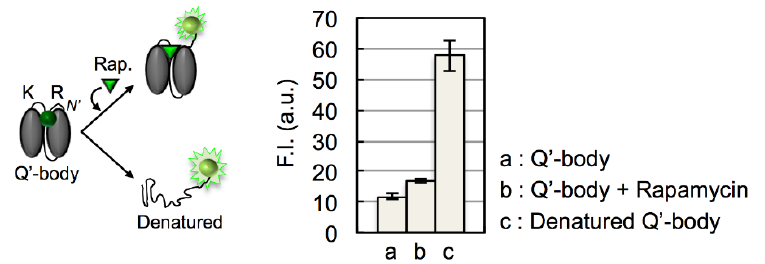
Figure A1. Schematic representation of quenched, de-quenched and denatured Q’-body ( left ); and the maximum fluorescence intensity for each Q’-body ( right ). In b and c, 1 µM rapamycin and 7 M GdnHCl/100 mM DTT were added, respectively. Error bars represent ±1 SD ( n =